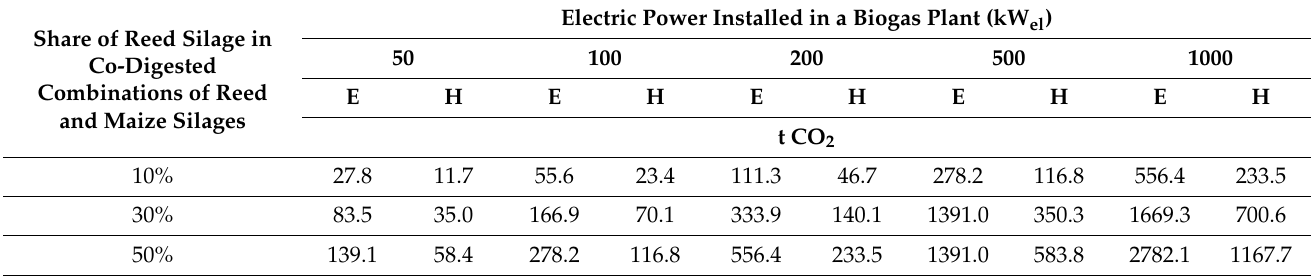
Table 8. CO 2 emissions avoided by using reed as a co-substrate in a biogas